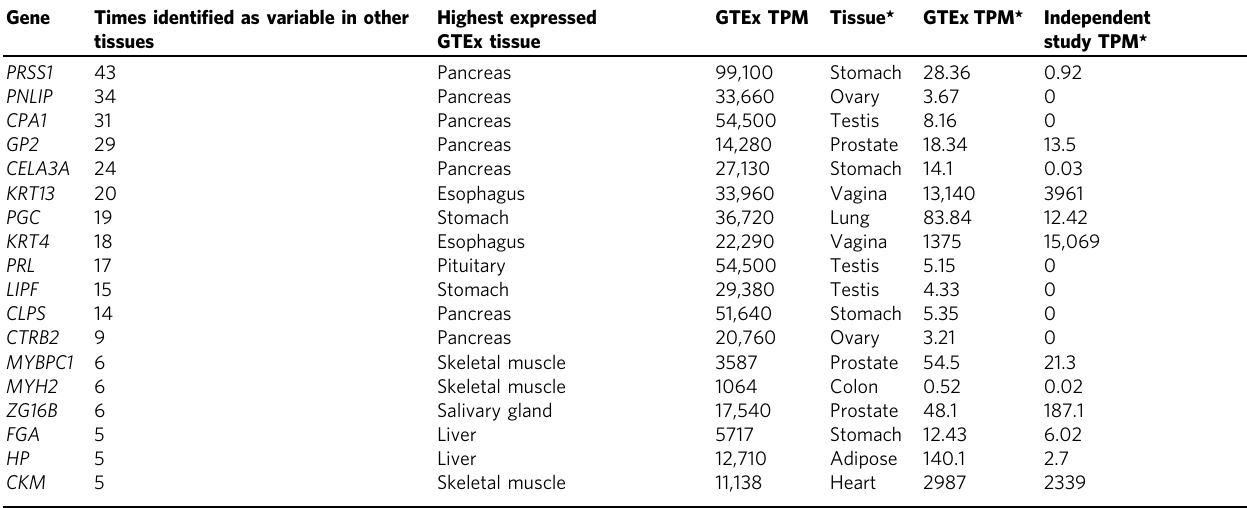
Table 1 Eighteen highly expressed genes that appear to contaminate fi ve or more GTEx tissues. Gene Times identi fi ed as variable in other tissues